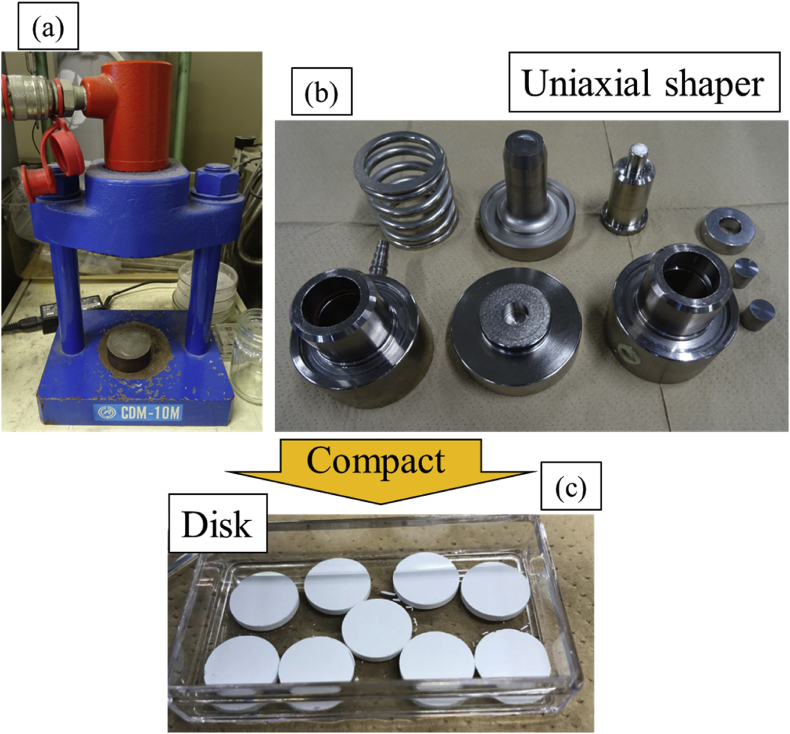
Disk molding example of silica particles. (a) Compression molding machine, (b) Mold parts, (C) Silica disk after molding.